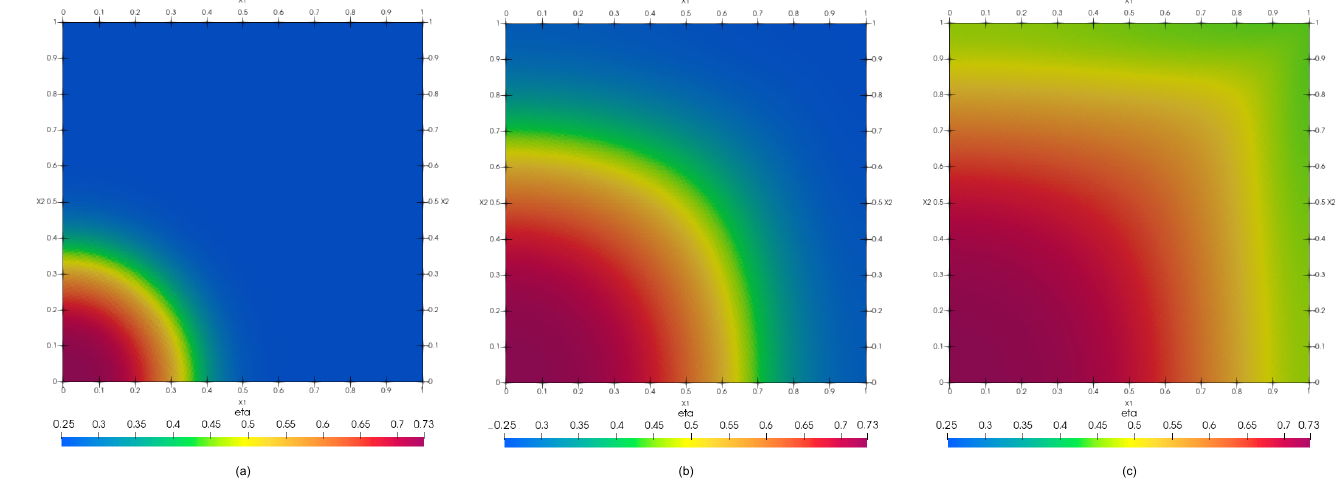
Figure 1. Dynamics of the effective saturation η at different times t . ( a ) t = 1000 τ , ( b ) t = 4000 τ , and ( c ) t = 9000 τ with τ = 10 − 3